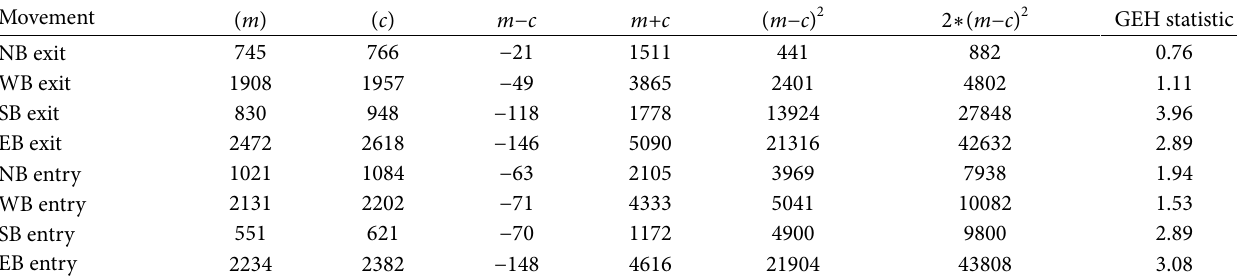
Table 4: GEH statistic calculations for calibration’s model.